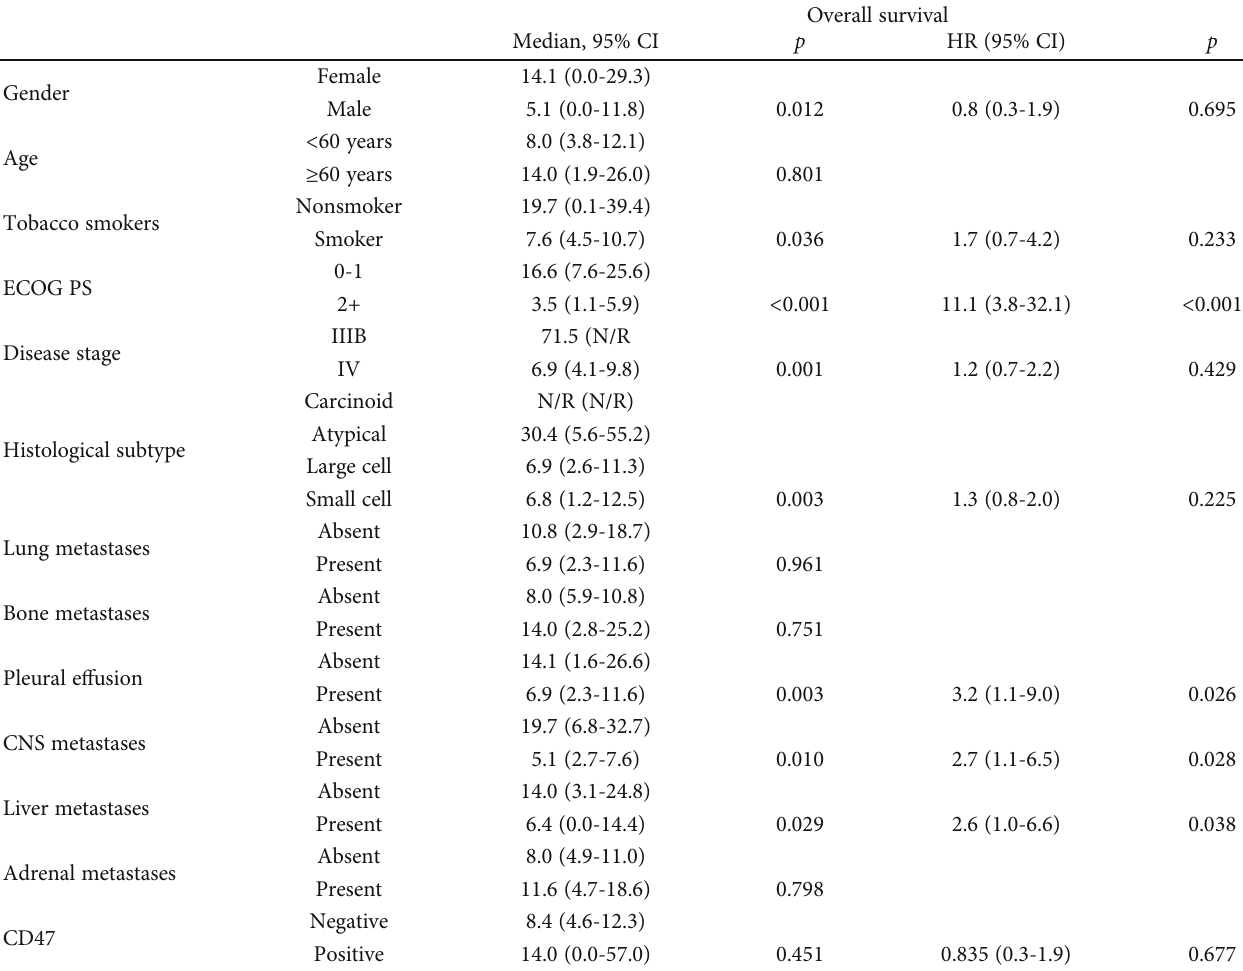
Table 3: Univariate and multivariate analysis for factors associated with